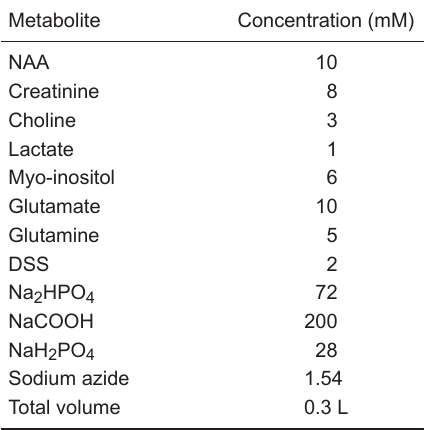
Table 1. Metabolite concentrations used in the magnetic resonance spectroscopy